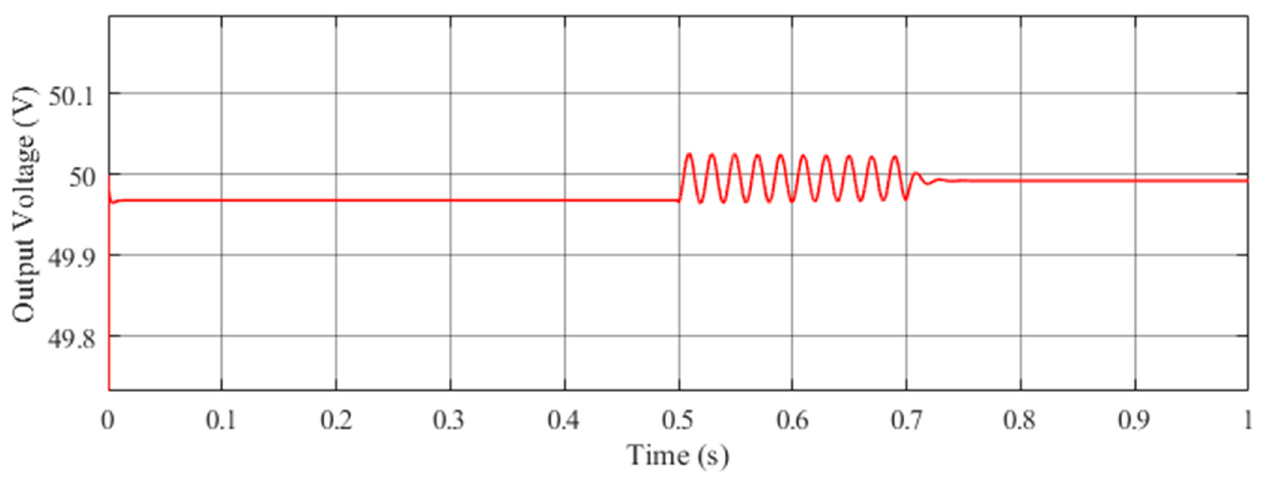
Figure 16. Frequency regulation during fault.